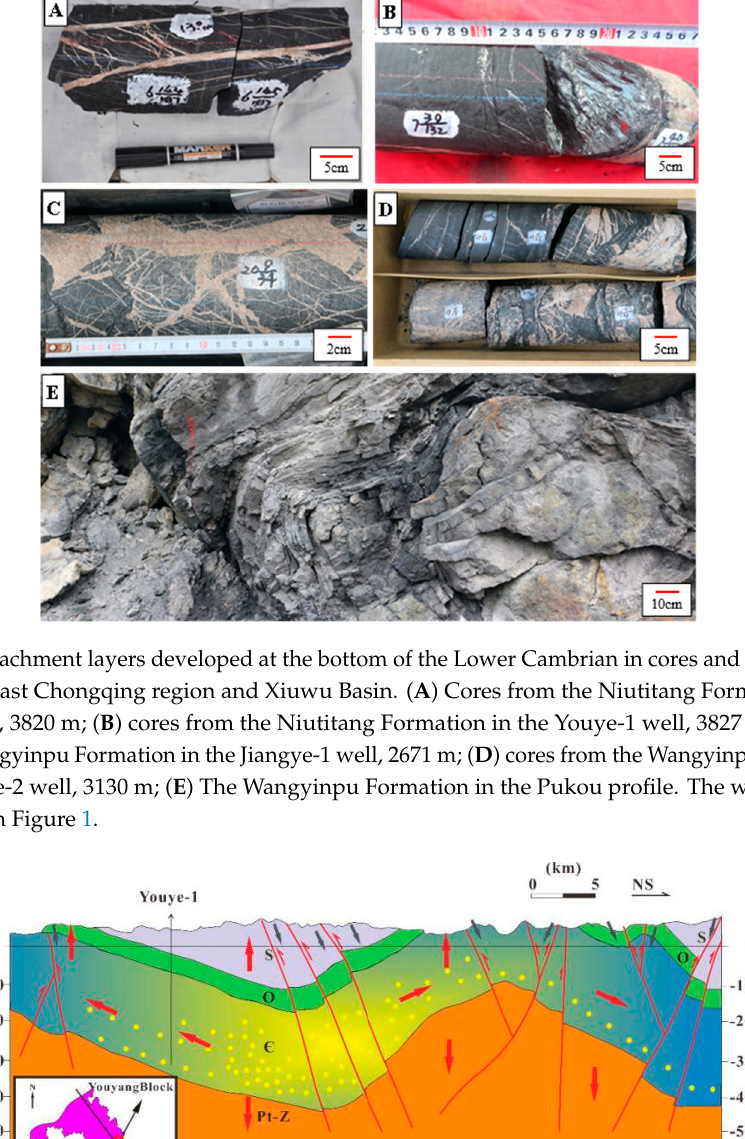
Figure 7. Seismic interpretation results for Southeast Chongqing region.